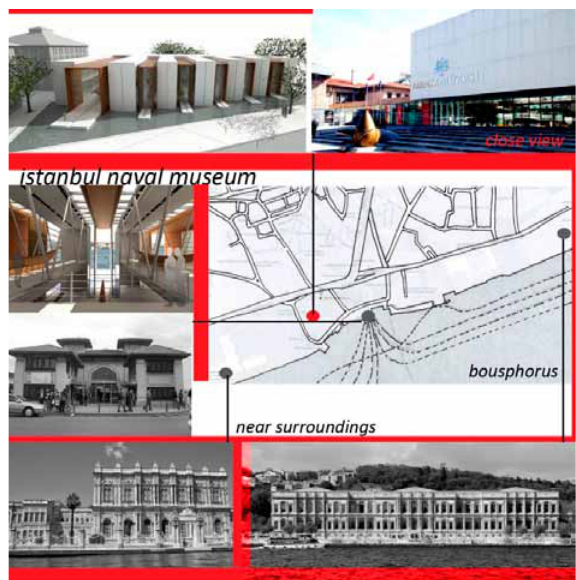
fig. 19. Istanbul naval Museum, collage by